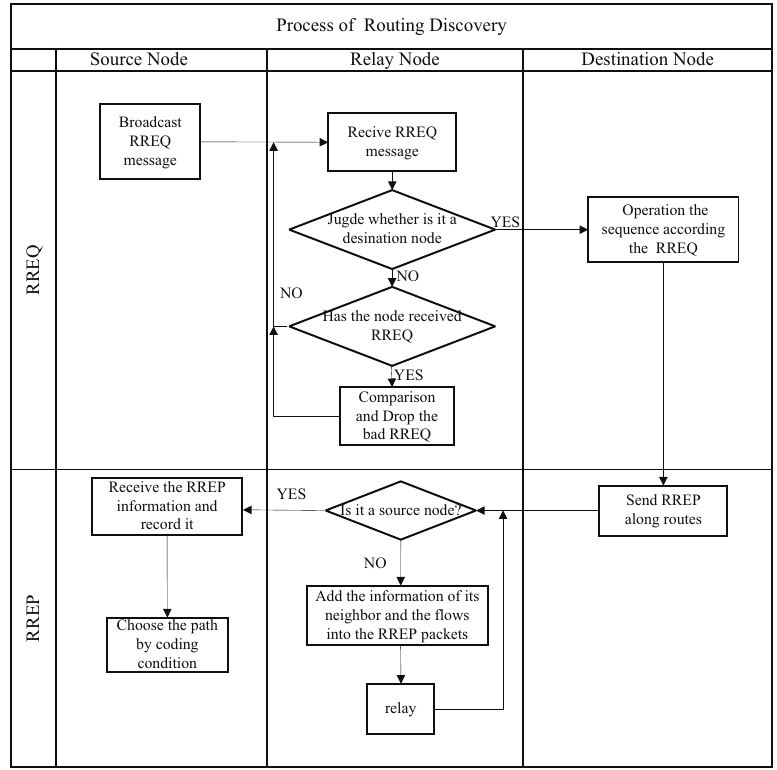
Figure 5. The flowchart of routing